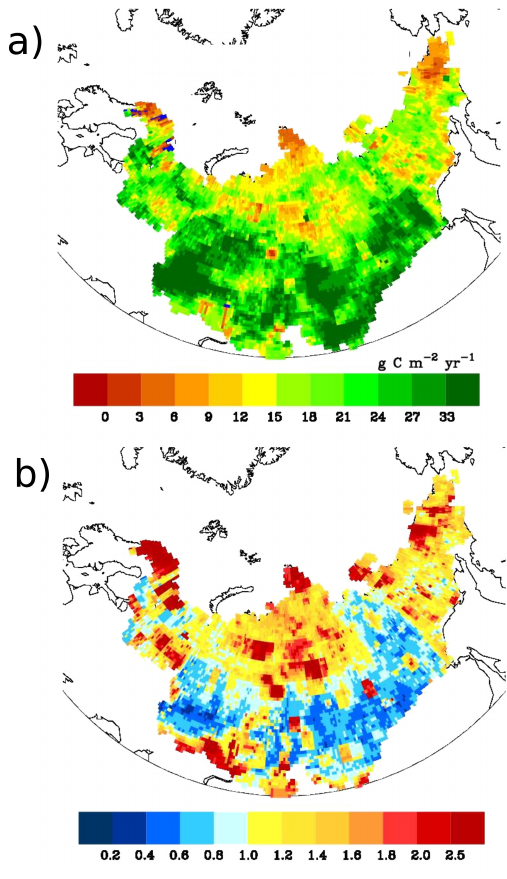
Figure 8. (a) Annual NEP (1960–2009) averaged across the nine models. Areas in blue are a net annual source of CO 2 . (b) Coef- ficient of variation as estimated from the across model mean and standard deviation for each grid.